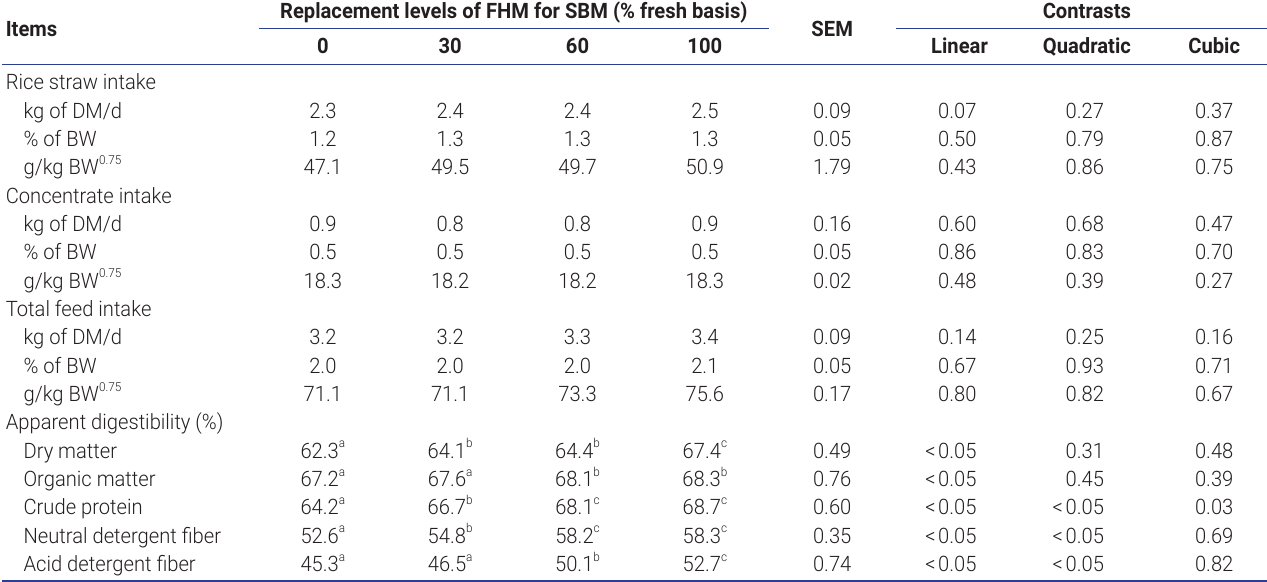
Table 2. Flemingia as a protein source fodder on voluntary feed intake and nutrient digestibility in beef cattle Replacement levels of FHM for SBM (% fresh basis) Items